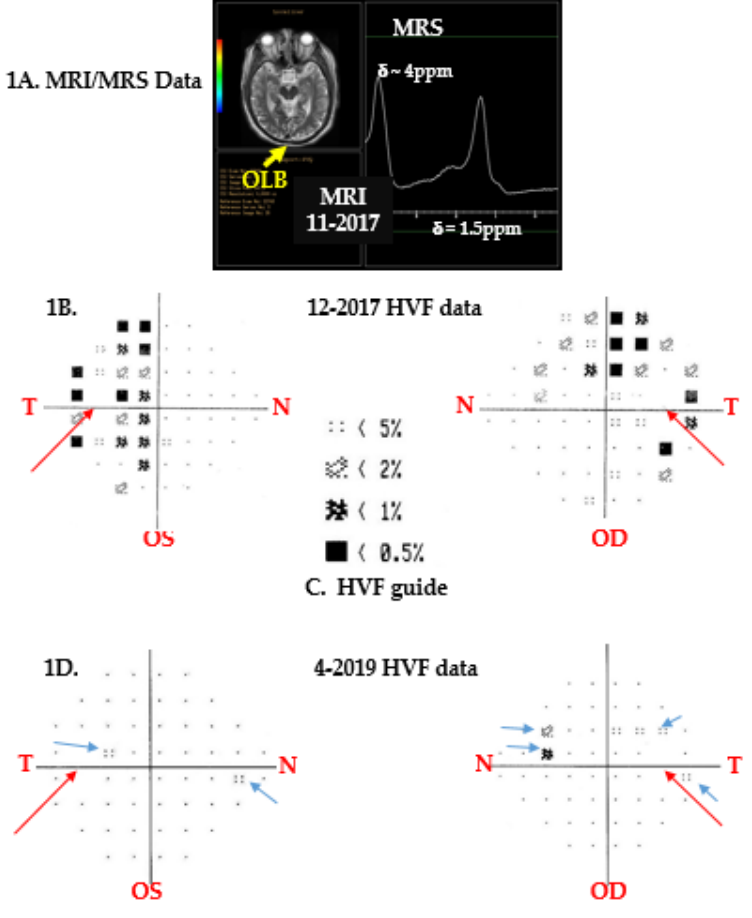
Figure 1. Patient’s tumor and Humphrey’s Visual Field Data.